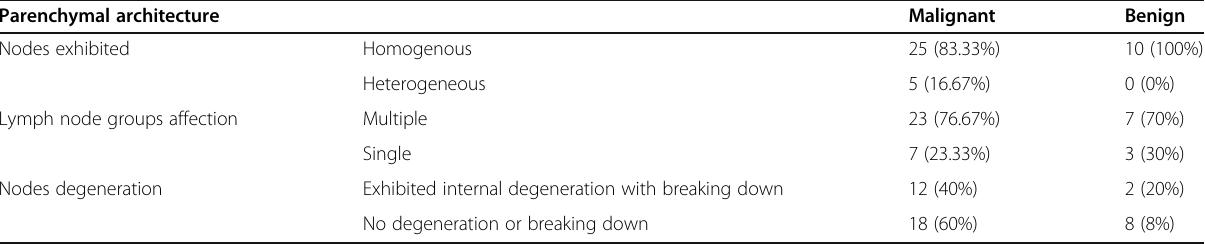
Table 2 The parenchymal architecture of malignant and benign lymphadenopathy Parenchymal architecture Malignant Benign Nodes exhibited Homogenous 25 (83.33%) Heterogeneous Lymph node groups affection Multiple Single Nodes degeneration Exhibited internal degeneration with breaking